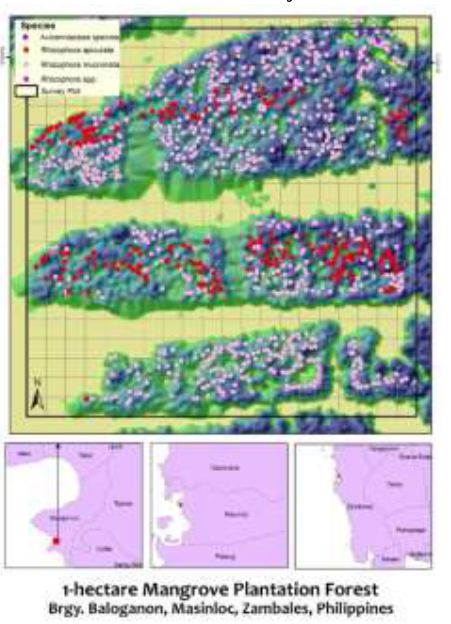
Figure 1. Location Map of the study site in Brgy. Baloganon, Masinloc,